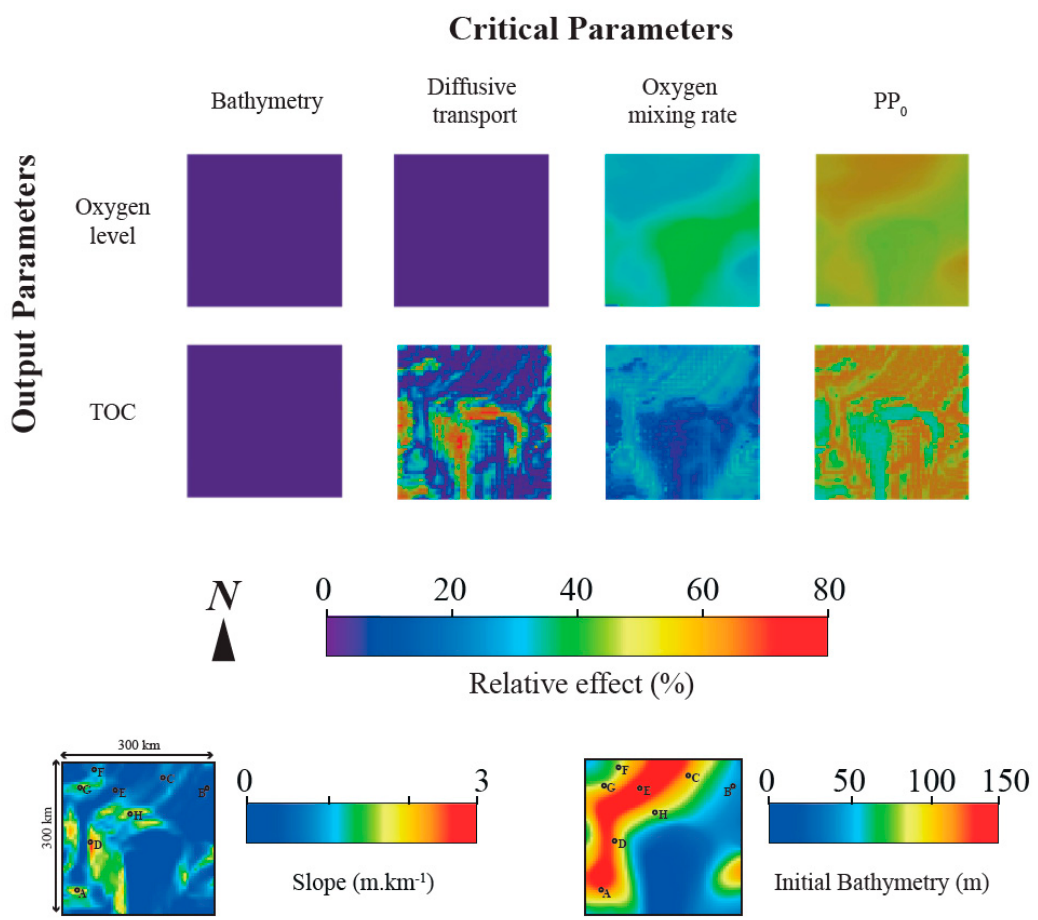
Figure 10. Global sensitivity analysis relative effect maps for the interval 3 (181.7 to 181.5 Ma). Slope and Initial Bathymetry are also presented for comparison.